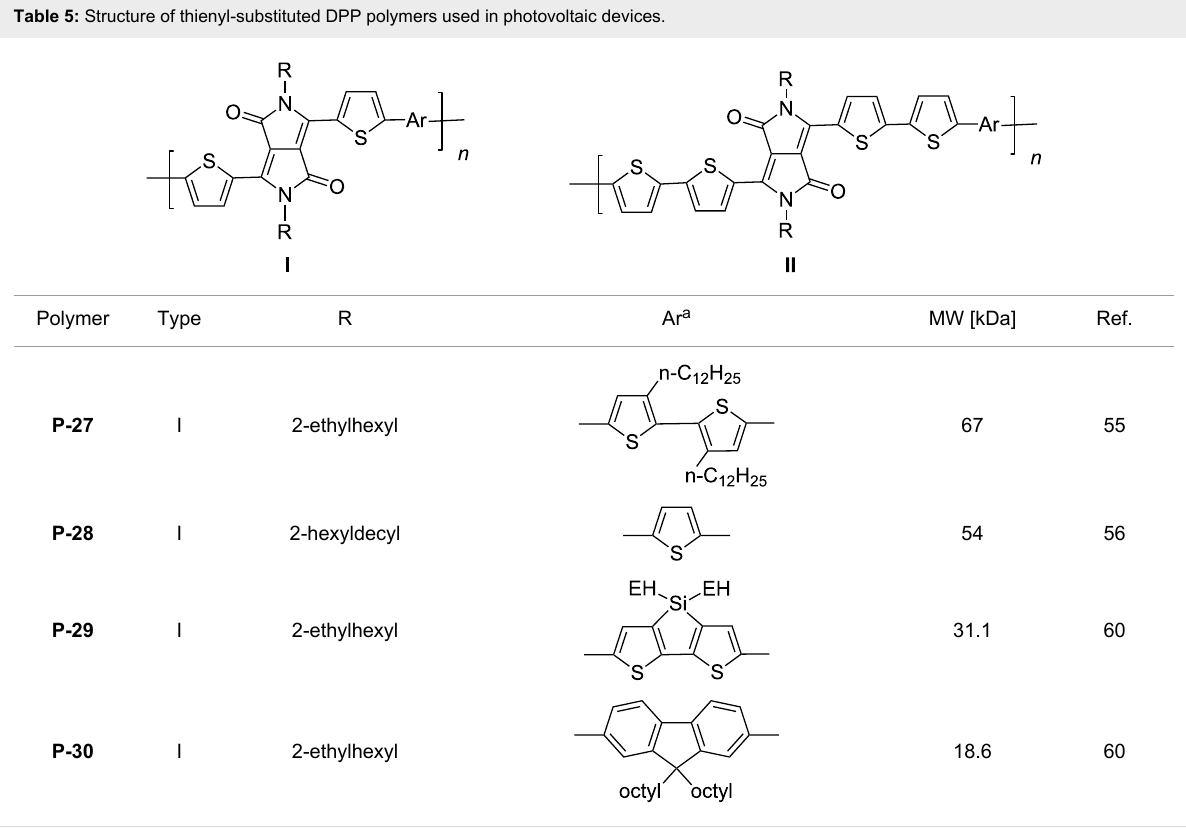
Table 5: Structure of thienyl-substituted DPP polymers used in photovoltaic